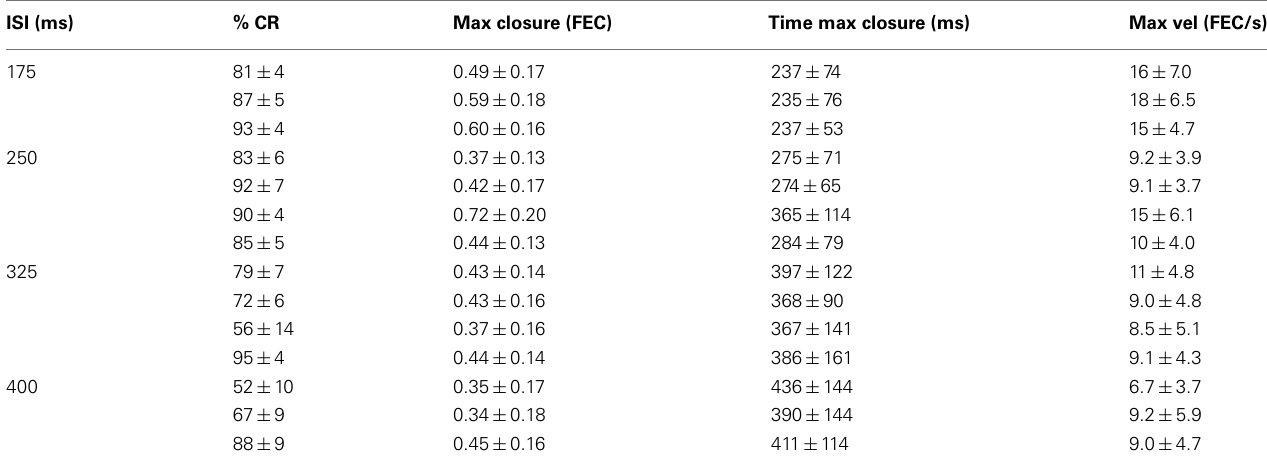
Table 1 | Kinematic properties of the average conditioned eyelid response for each of the mice in this study. ISI